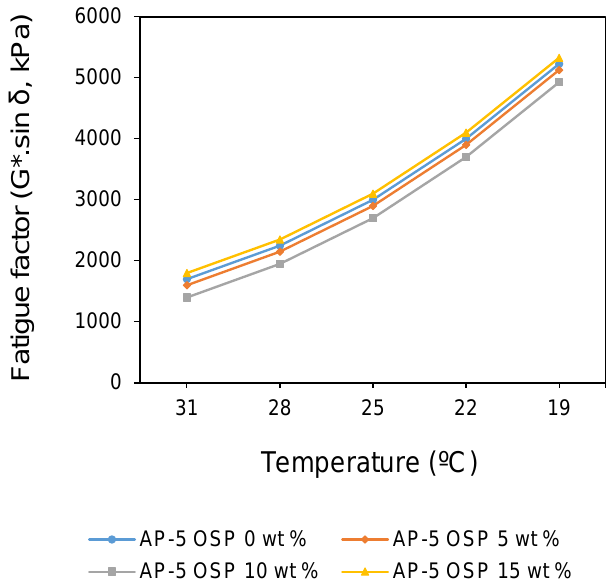
Figure 10. Effect of temperature on the fatigue cracking parameter of unfilled and OSP-filled asphalts under long-term aging condition (PAV: pressure aging vessel).